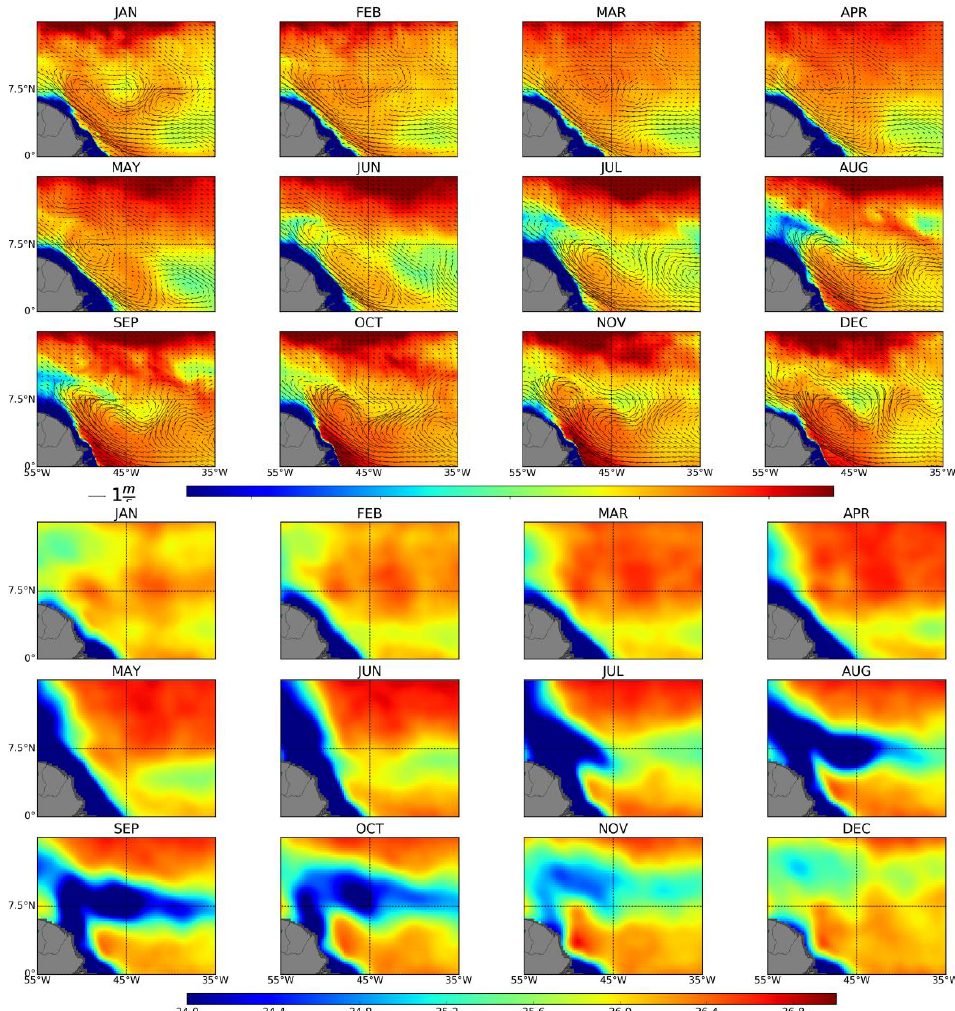
Figure 2. (Top panels) Monthly mean SSS (colored) and surface velocity field (velocity vectors) from January 2011 to December 2015 for HYCOM at 1/12° resolution in the NBCR. (Bottom panels) The same using SMOS data but without velocity